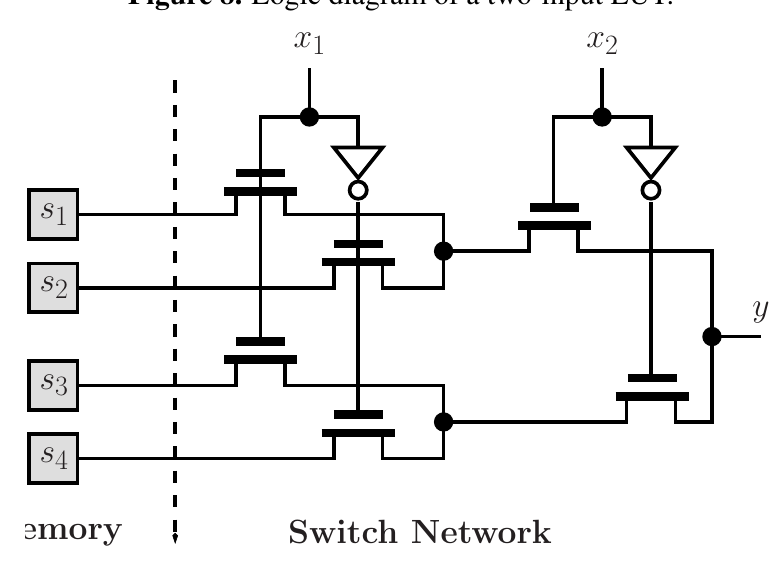
Figure 8. Logic diagram of a two-input